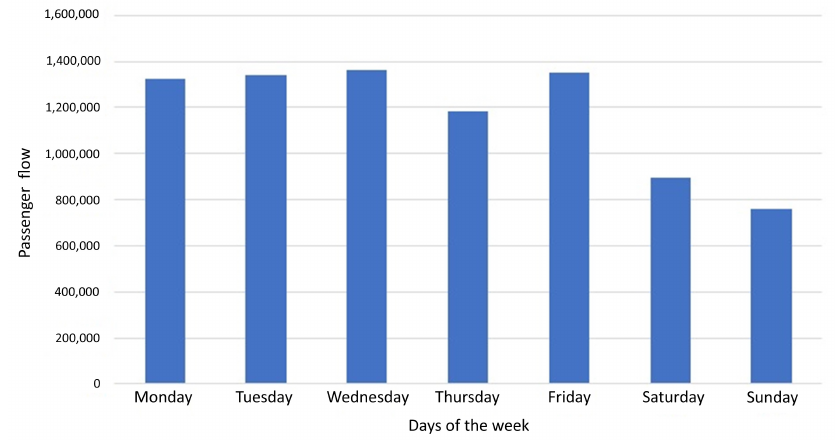
Figure 3. Daily metro passenger